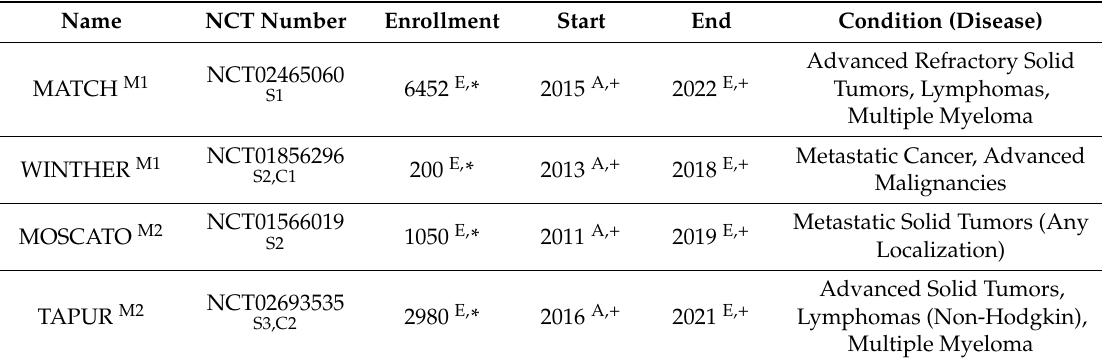
Table 4. Summary of non-randomized histology-agnostic studies examined in this article. Data extracted from clinicaltrials.gov (October,